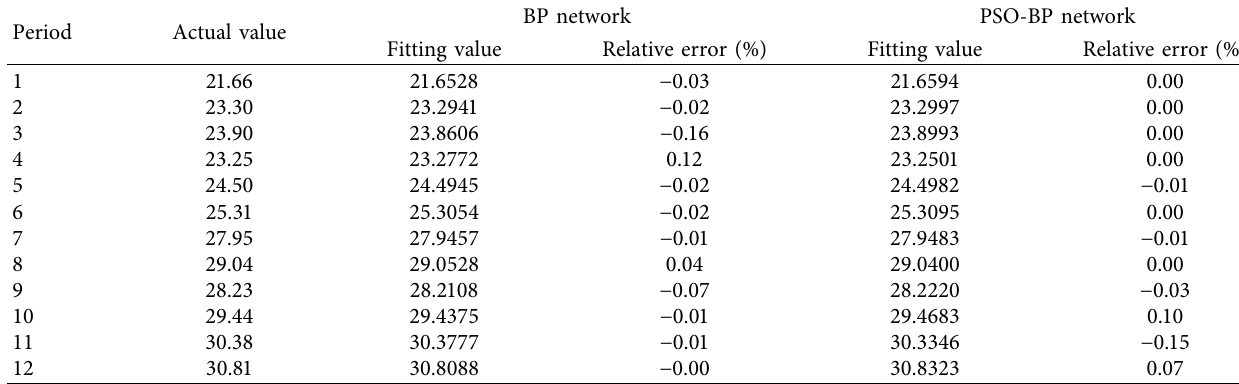
Figure 22: PSO-BP network test sample. Table 12: B16 actual value and model fitting value results.